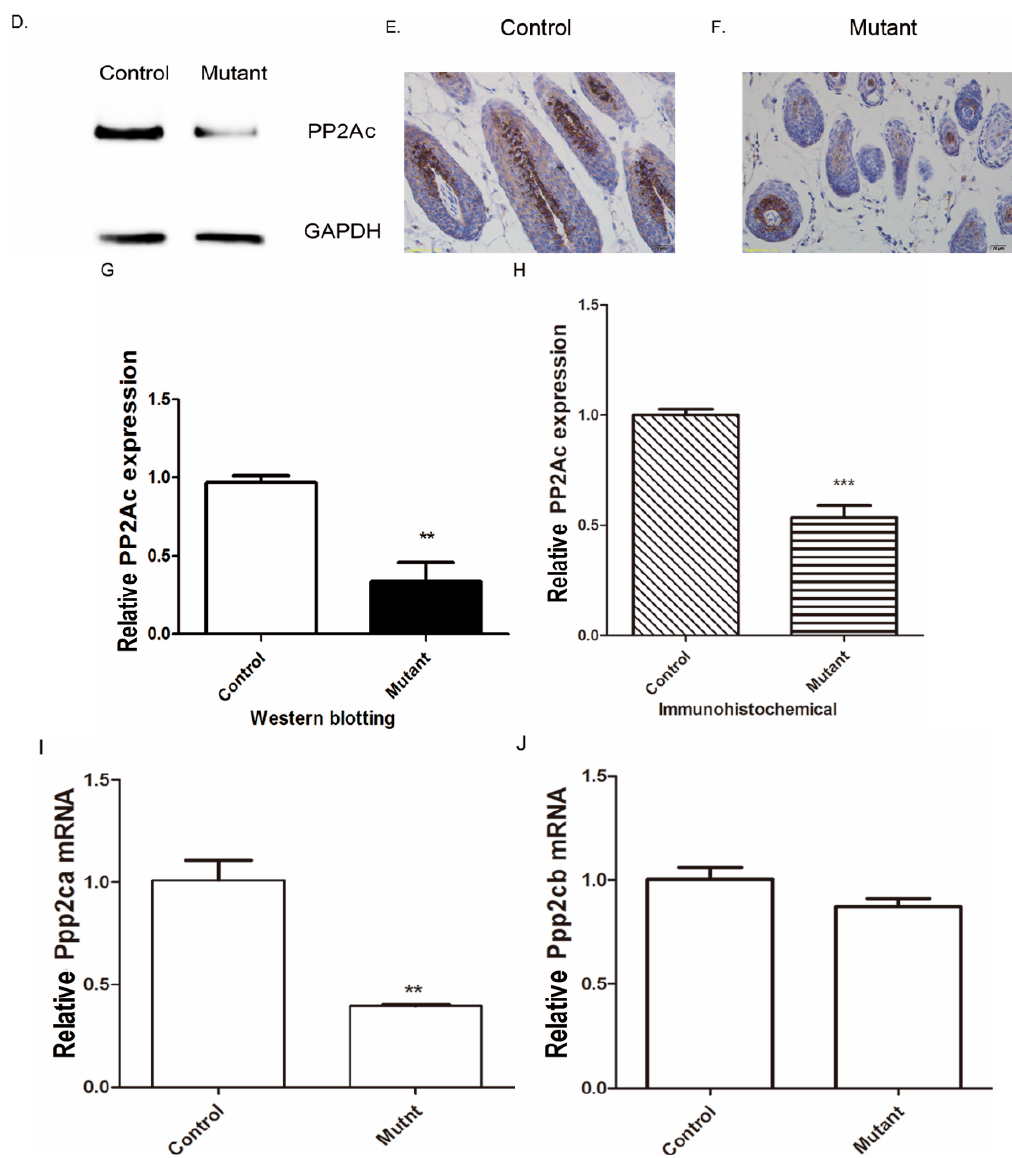
Figure 1. Development of Ppp2ca conditional knockout mice. ( A ) The recombination process and the Loxp sites used for knocking out Ppp2ca ; ( B ) Ppp2ca flox/flox ; Krt14-Cre was subjected to PCR analysis. Lanes 1, 2, and 3 represent the wild-type (WT), Ppp2ca flox/flox and Ppp2ca flox/+ , respectively; ( C ) Back skin of the Ppp2ca flox/flox ; Krt14-Cre (lane 4), Ppp2ca flox/+ ; Krt14-Cre (lane 5) and WT (lane 6) mice were analyzed by reverse transcription PCR. Detection of transcripts shorter than the control mice transcript in mutant mice indicated that the knockout was successful; ( D ) Western blotting with the anti-PP2Ac antibody was used to detect PP2Ac protein expression in the skin of Ppp2ca flox/+ ; Krt14-Cre and Ppp2ca flox/flox ; Krt14-Cre littermates. PP2Ac expression was significantly lower in mutant mice than in controls. The loading control was GAPDH; ( E , F ) PP2Ac expression in the hair follicle epithelium of mutant mice was significantly reduced. Scale bars = 20 μ m; ( G , H ) Statistical analysis indicated that PP2Ac was significant reduced in mutant mice skin; ( I , J ) Quantitative real-time PCR assay was carried out to examine the expression levels of Ppp2ca and Ppp2cb mRNA. n = 3 in each group, ** p < 0.01, *** p < 0.001.